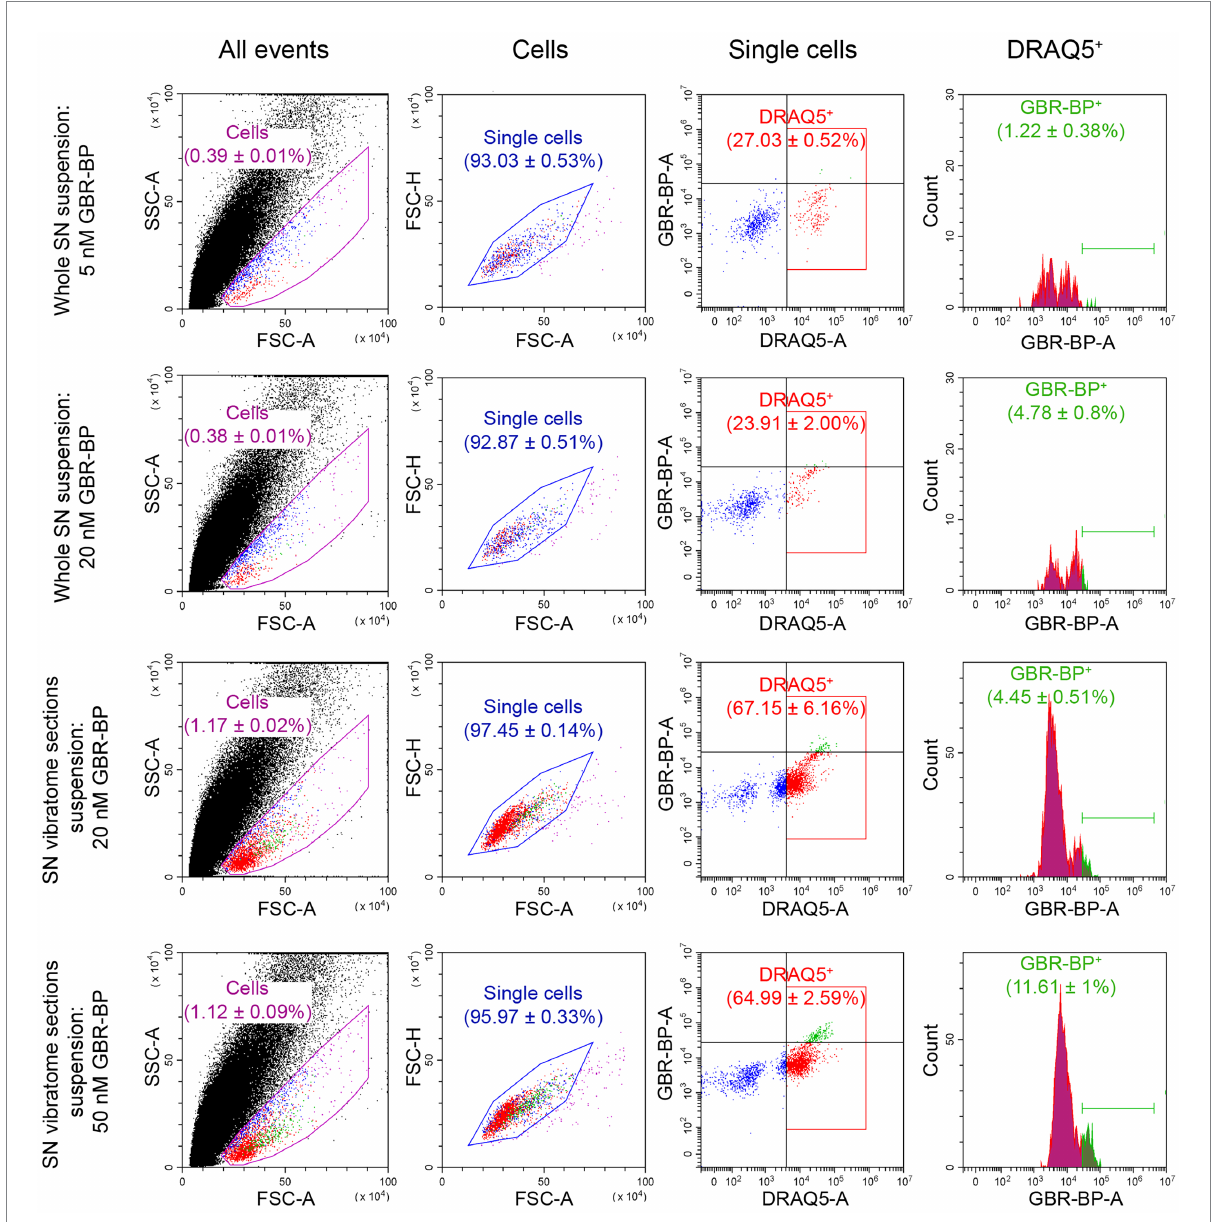
FIGURE 2 Quantification of substantia nigra (SN) cell suspension by flow cytometry after using various methods for cell dissociation and staining with DRAQ5 and GBR-BP. For each measurement n = 3. CTCF, corrected total cell fluorescence; DRAQ5 + , DRAQ5-stained cells; FSC, forward scatter; GBR-BP + , GBR-BP-stained cells; SSC, side